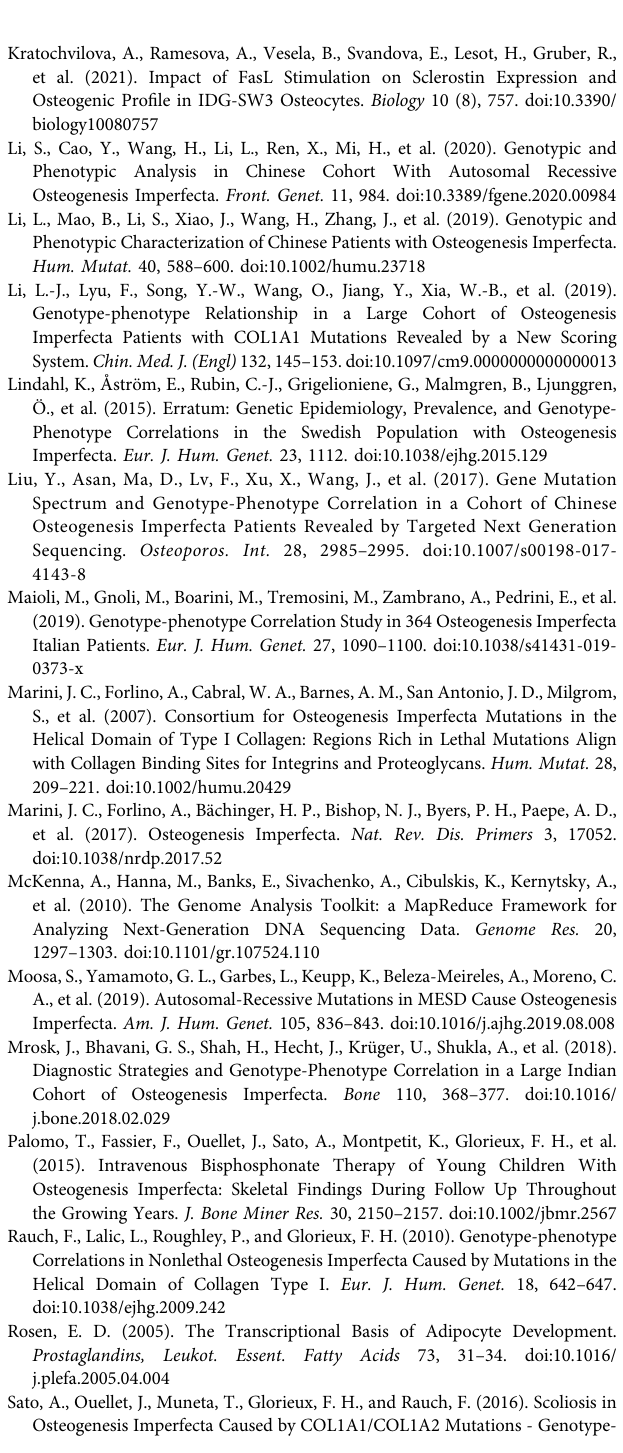
Supplementary Figure S1 | DEGs between control and OI-COL1. Supplementary Figure S2 | Growth curves and inter-group comparisons. Supplementary Figure S3 | Growth curves and treatment responses. Supplementary Figure S4 | Radiographic images of eight patients carrying COL1A1 c.2461G > A, p.Gly821Ser mutation.